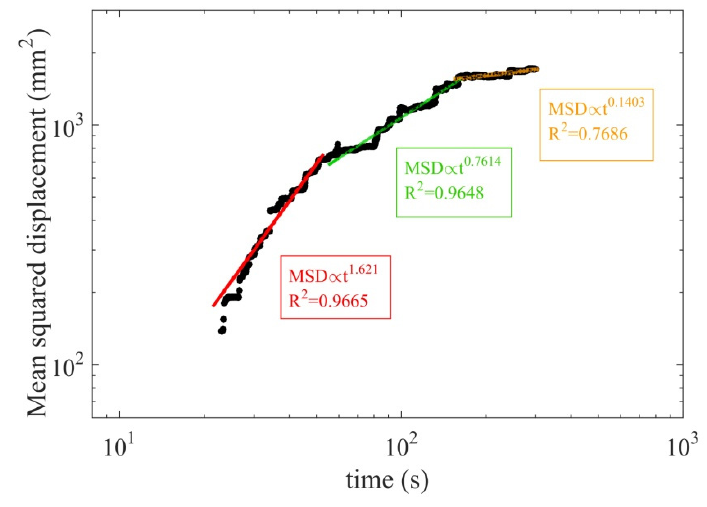
Figure 2. Mean squared displacement (MSD) versus time for tracer bed load particles.